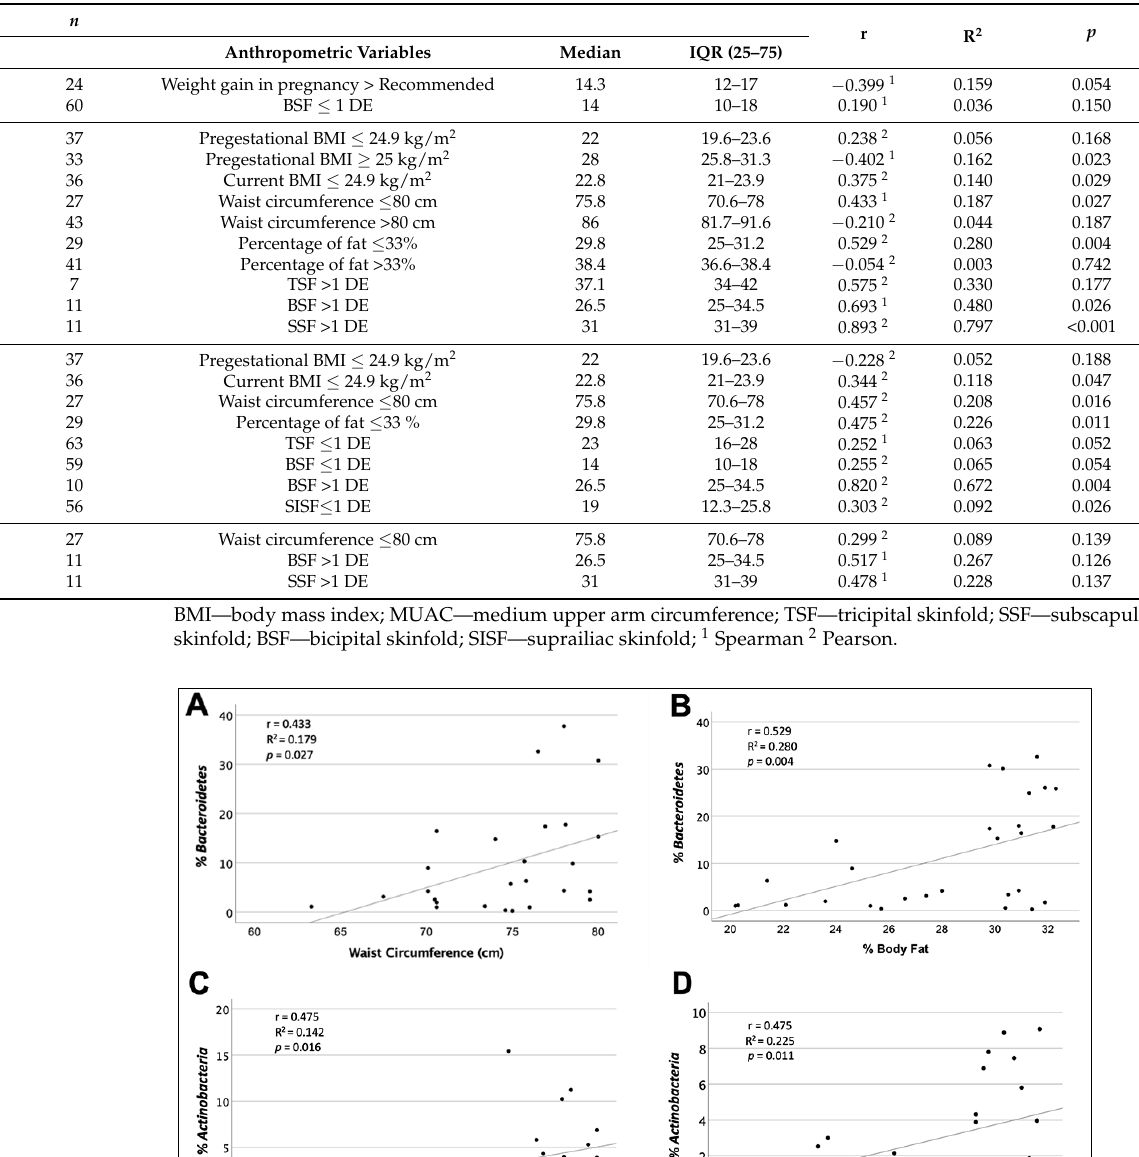
Table 3. Correlation and regression coefficients of the percentage of human milk bacterial phyla with maternal anthropometric variables in 70 nursing mothers.